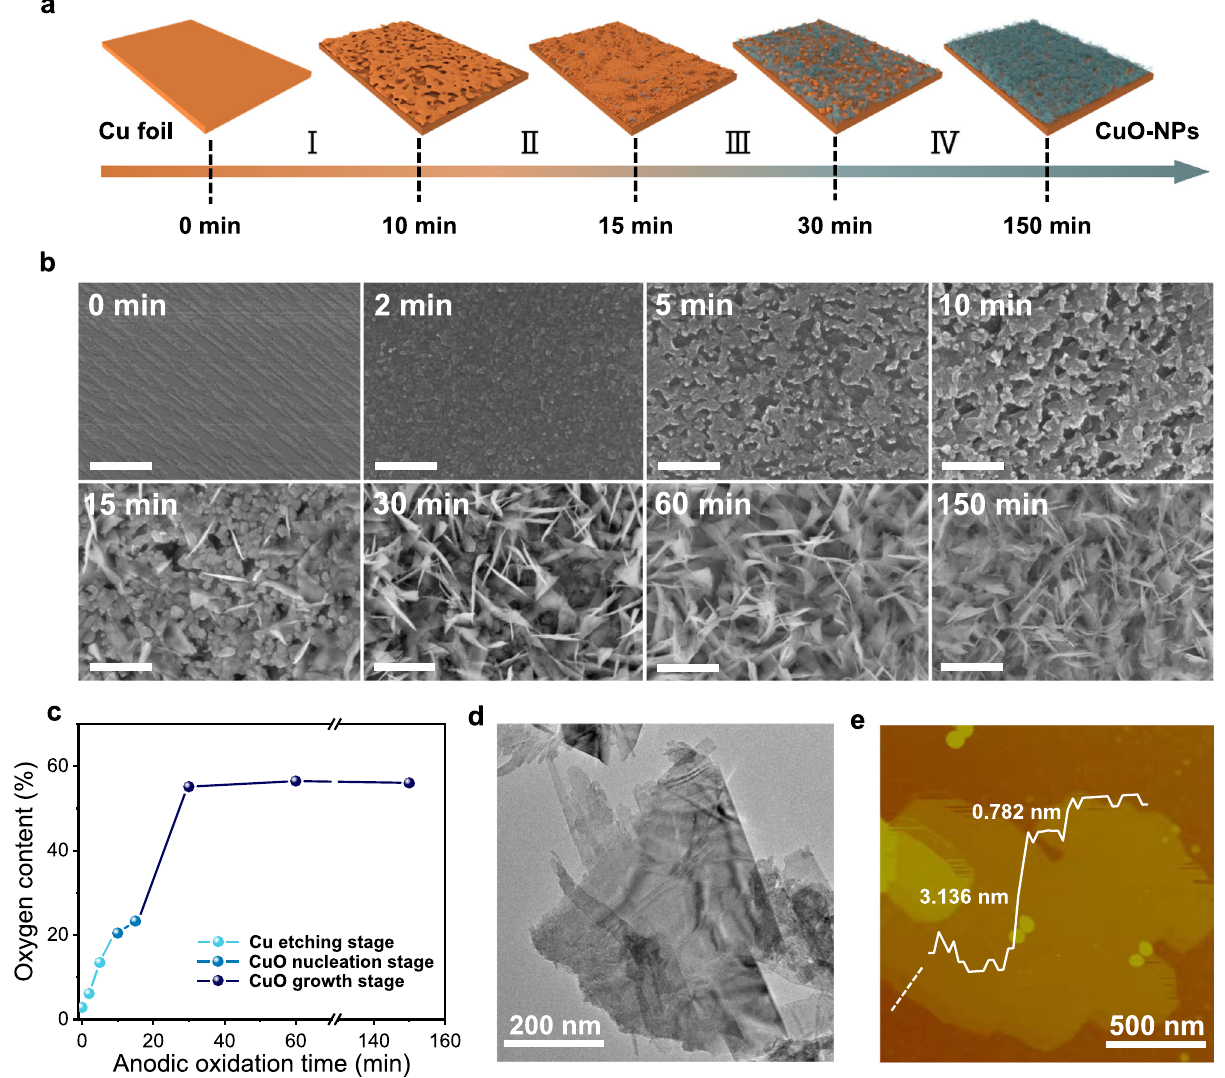
Fig. 1 Preparation and characterization of CuO-NPs. a Schematic illustration of the preparation of CuO-NPs. b SEM images of Cu foils at different anodic oxidation times. The scale bars are 500 nm. c Oxygen content of the Cu surface at different anodic oxidation times. d TEM image of the CuO-NPs. e AFM image of the CuO-NPs and the corresponding height pro fi le from the dashed